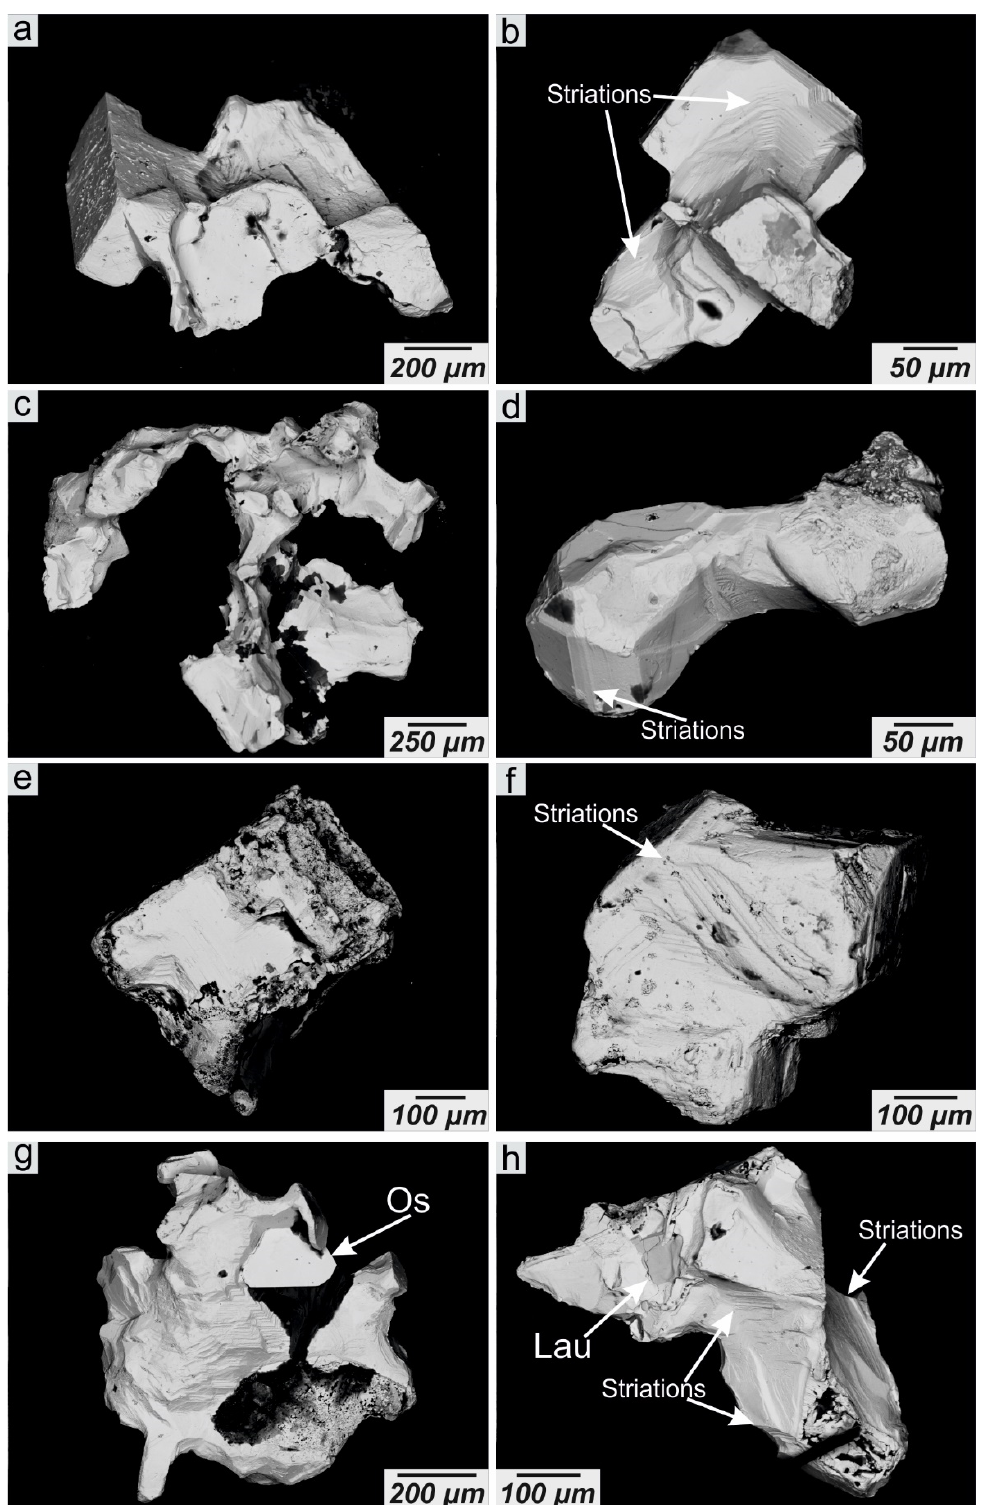
Figure 4. The morphological features of Pt-Fe alloy grains from lode chromite-platinum mineralization ( a – d ) and Vershinniy eluvial placer ( e – h ). Os—osmium, Lau—laurite. The g photo was published in Reference [25]. BSE images (SEM).